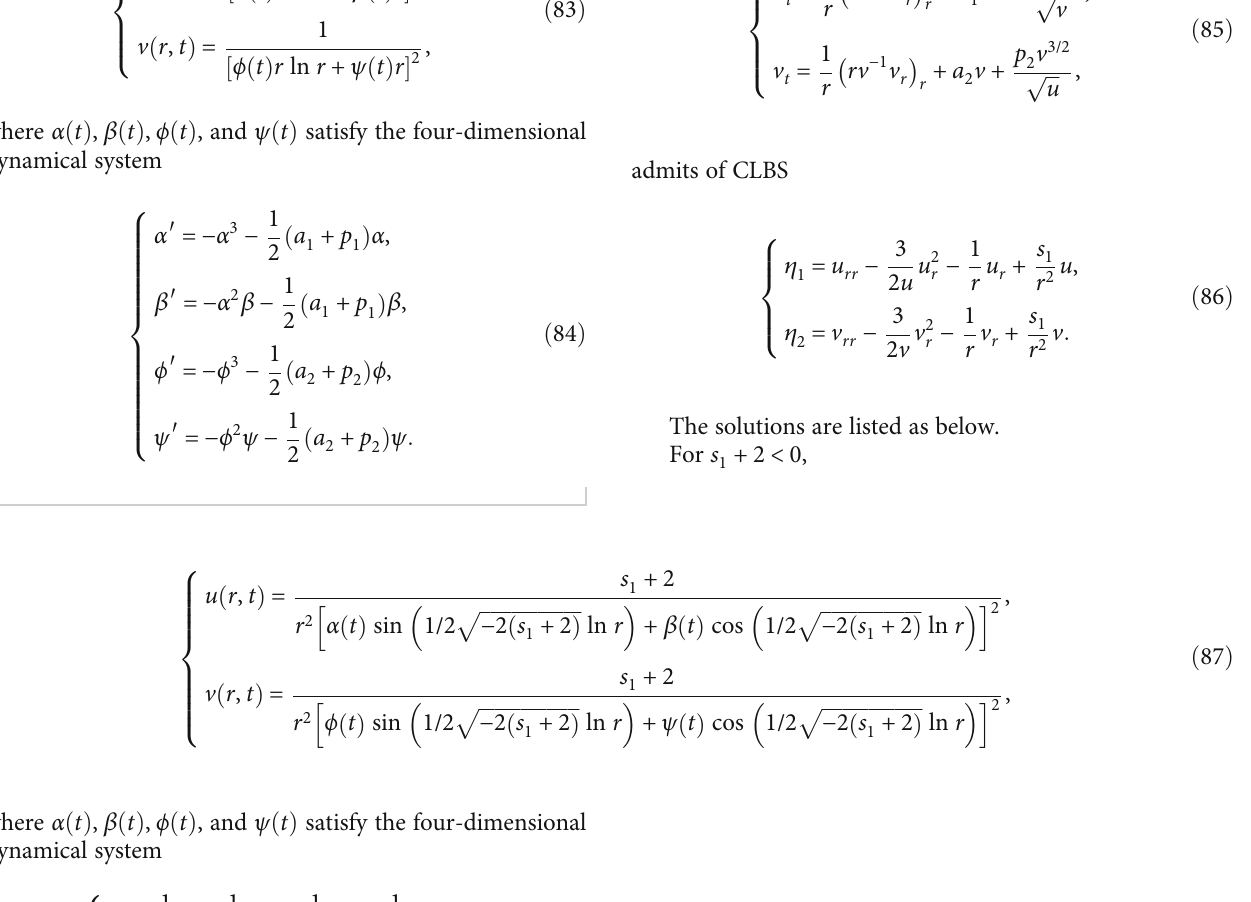
ffiffiffiffiffiffiffiffiffiffiffiffiffiffiffiffiffiffiffiffi − 2 s